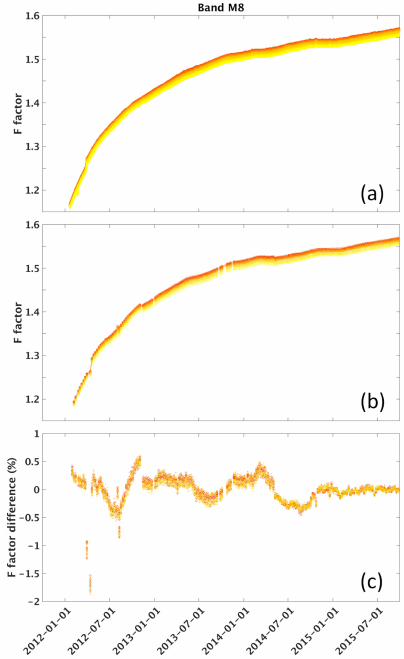
Figure A5. ( a ) VIIRS band M8 (1240 nm, single gain) radiometric calibration scaling coefficients (the F factors) derived by the automated calibration procedure; ( b ) the F factors used in the operational production of the VIIRS SDR; and ( c ) relative difference between the operational F factors and the reprocessed ones (used here as a baseline). Symbol legend is the same as in Figure 4.